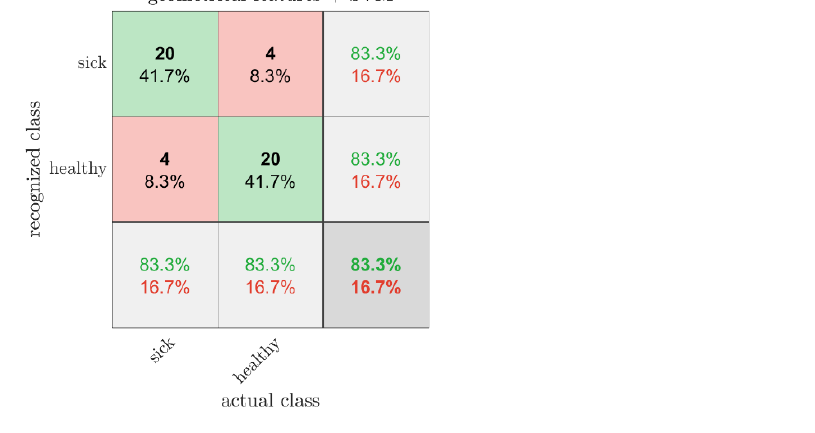
Figure 5. Error matrix showing the results of hypomimia recognition based on geometric features of facial images.